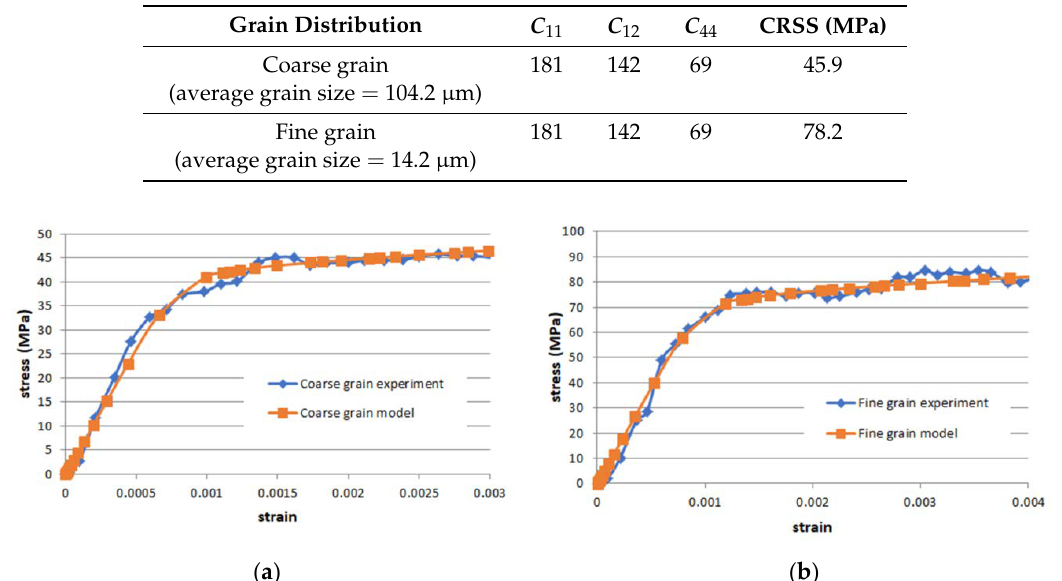
Table 4. Cyclic loading-computed parameters